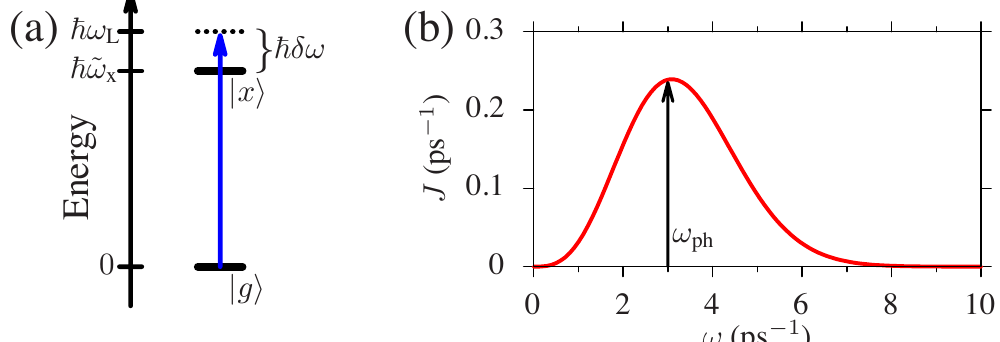
Figure 1. ( a ) Schematic plot of the two-level model with the optical excitation; ( b ) phonon spectral density for a QD with a 5-nm